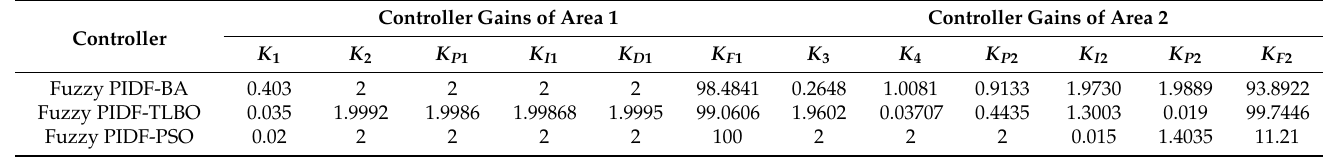
Table 19. Frequency response performances with different